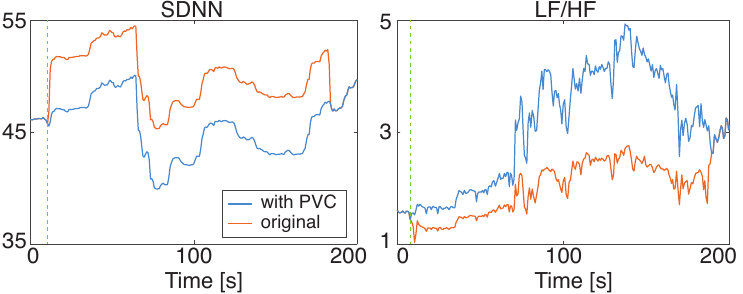
Figure 2. Influence of PVC on HRV features: SDNN ( left ) and LF/HF ( right ): The blue and red lines show the features extracted from the RRI data without PVC and with PVC, respectively. The vertical dashed line denotes the point of the PVC